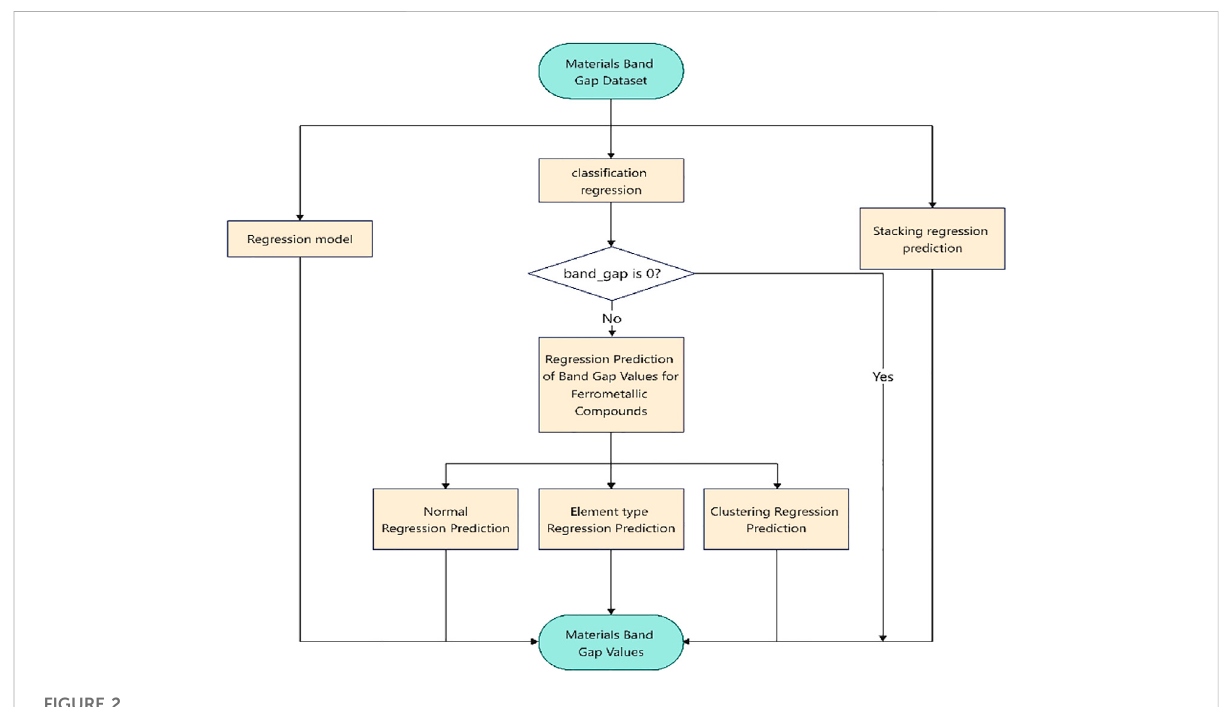
FIGURE 2 Experiment scheme fl ow chart.